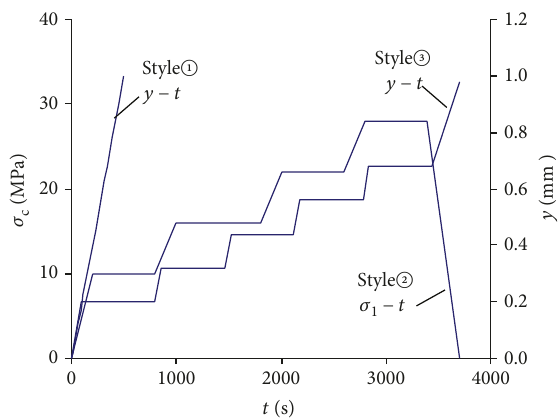
Figure 1: Schematic diagram of the three loading